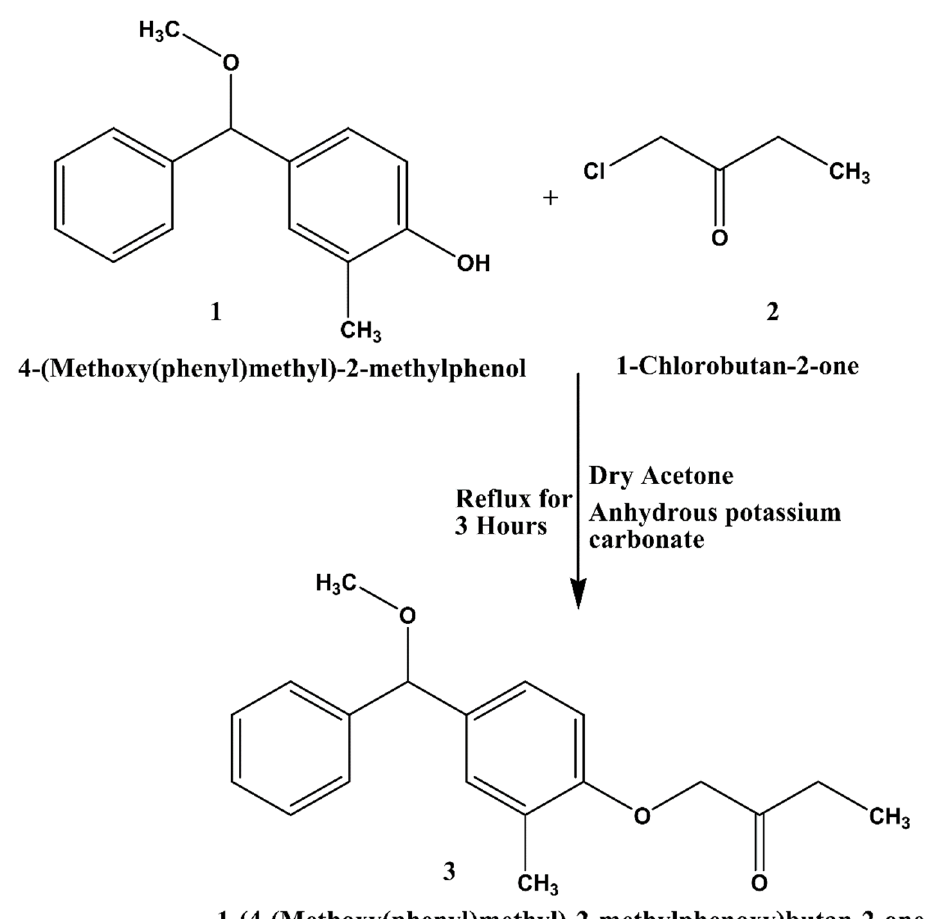
Figure 1. Synthesis of the crystal molecule.